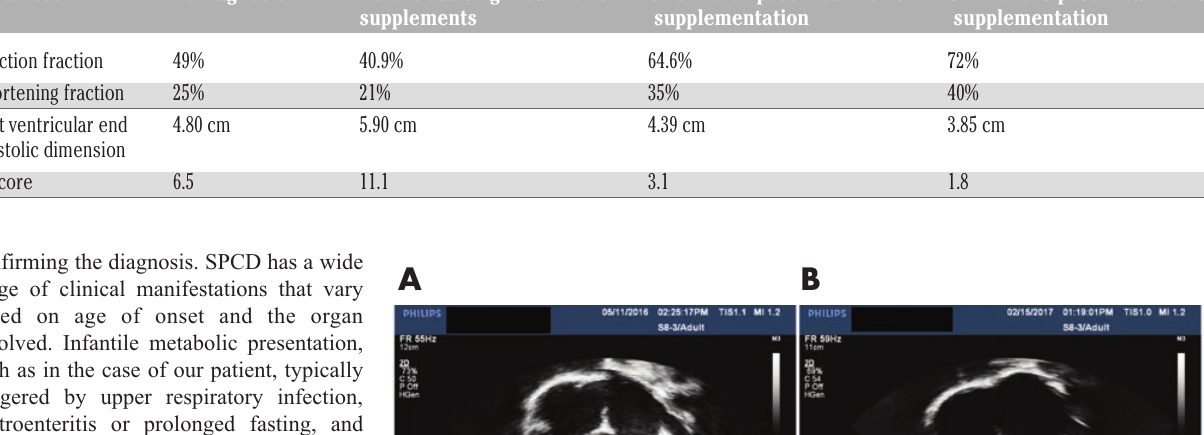
Table 1. Echocardiography findings of 5-year-old boy with systemic primary carnitine deficiency.